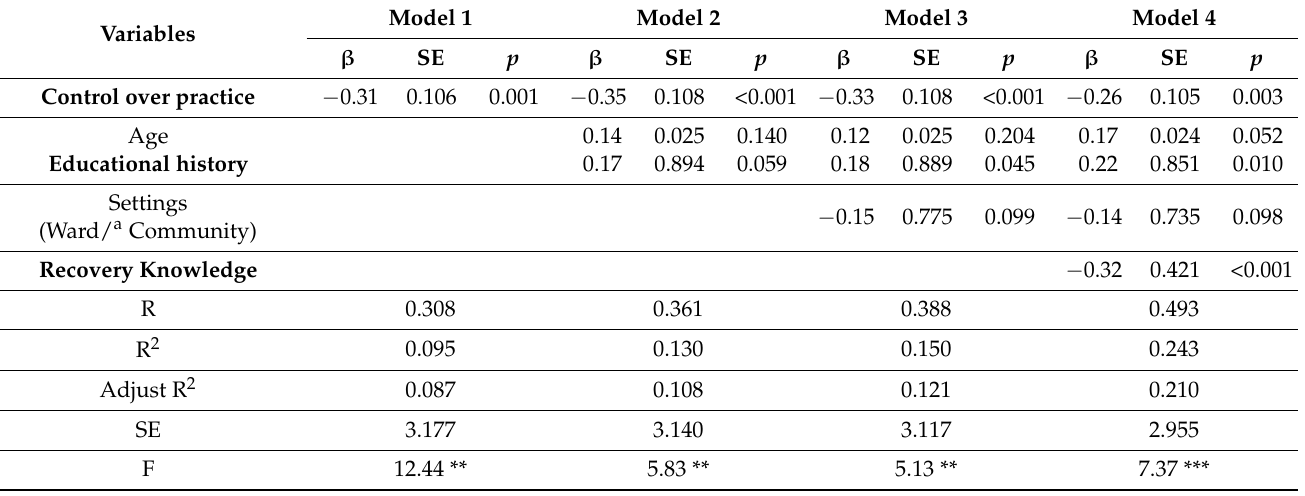
Table 3. The results of sub-group analysis among nurses ( n =